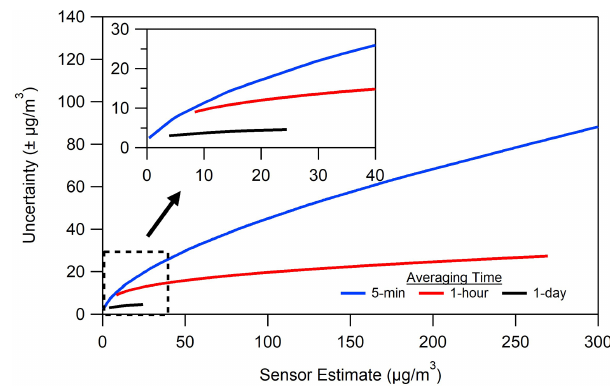
Figure 5. An alternative view of the prediction interval, which shows how this interval varies with concentration and with aver- aging time.